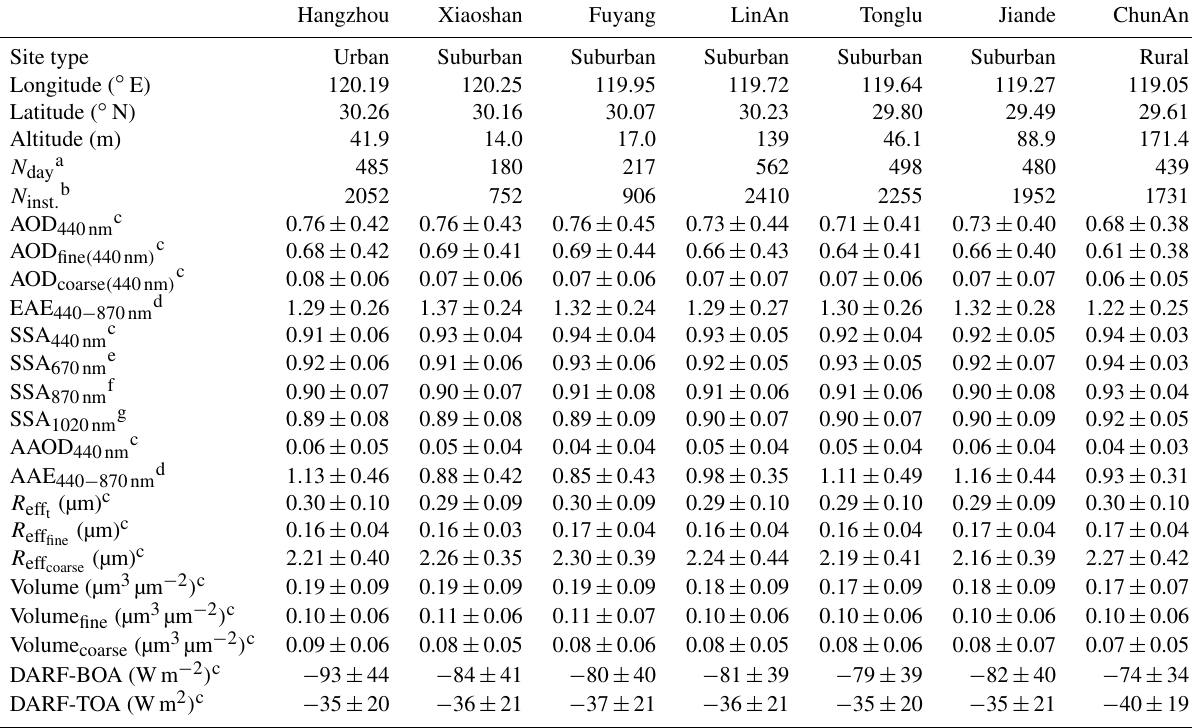
Table 1. Geographical location and annual arithmetic mean optical parameters for aerosols from seven sites in the Yangtze River Delta. Hangzhou Xiaoshan Fuyang LinAn Tonglu Jiande ChunAn Urban Suburban Suburban Suburban Suburban Suburban